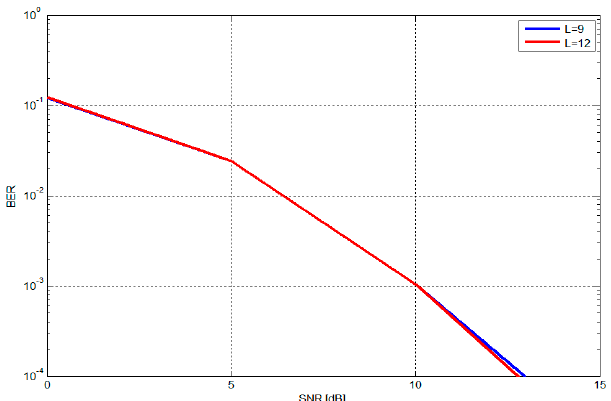
Figure 7. BER of STC OTDM at different channel taps L using QPSK.